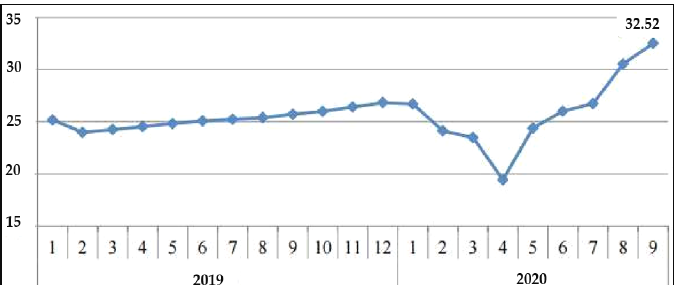
Figure 6. Weight of goods transported by inland waterways (million tons) (Vietnam Logistics Report 2020).